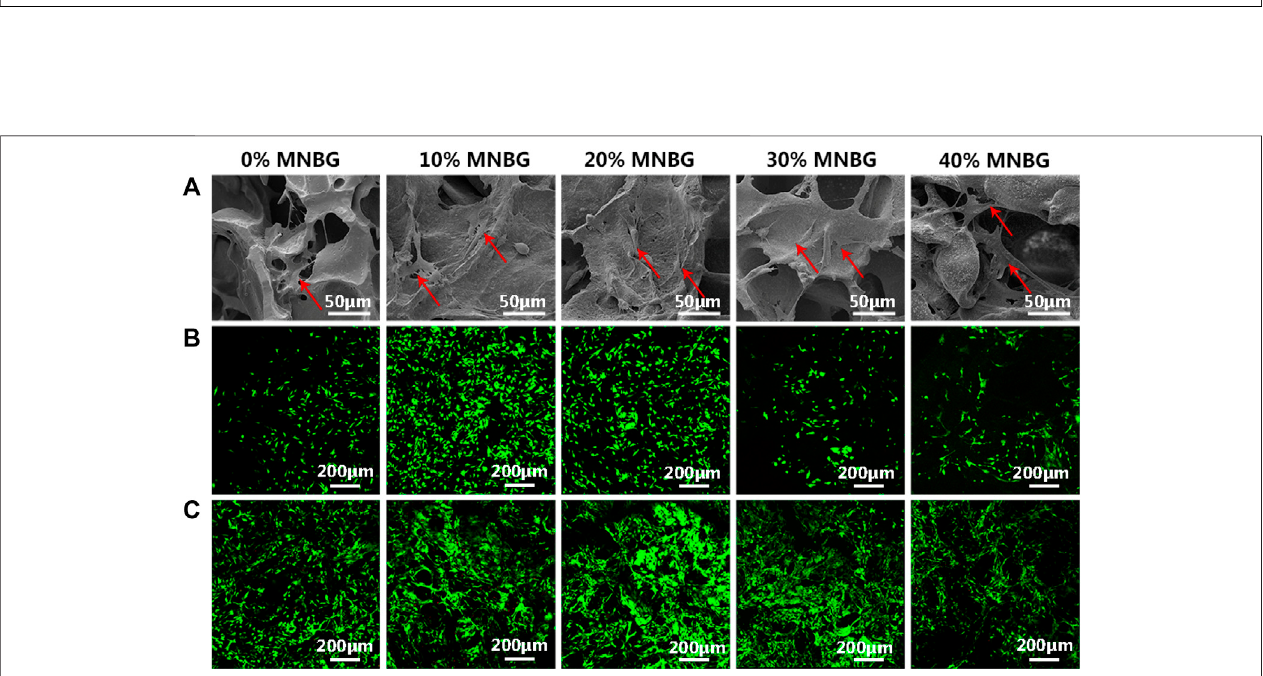
FIGURE4| Biodegradationandapatite-formingabilityofcompositescaffoldsinSBF. (A) MasslossbehaviorsofscaffoldsinSBFduring28 daysimmersing. (B,C) XRD patterns ofscaffolds after soakingin SBF for 3 days (B) and 7 days (C) . (D – F) Ionsrelease curves ofscaffolds for (D) Si; (E) Ca; (F) Pafter soaking inSBF for 3and 7 days.